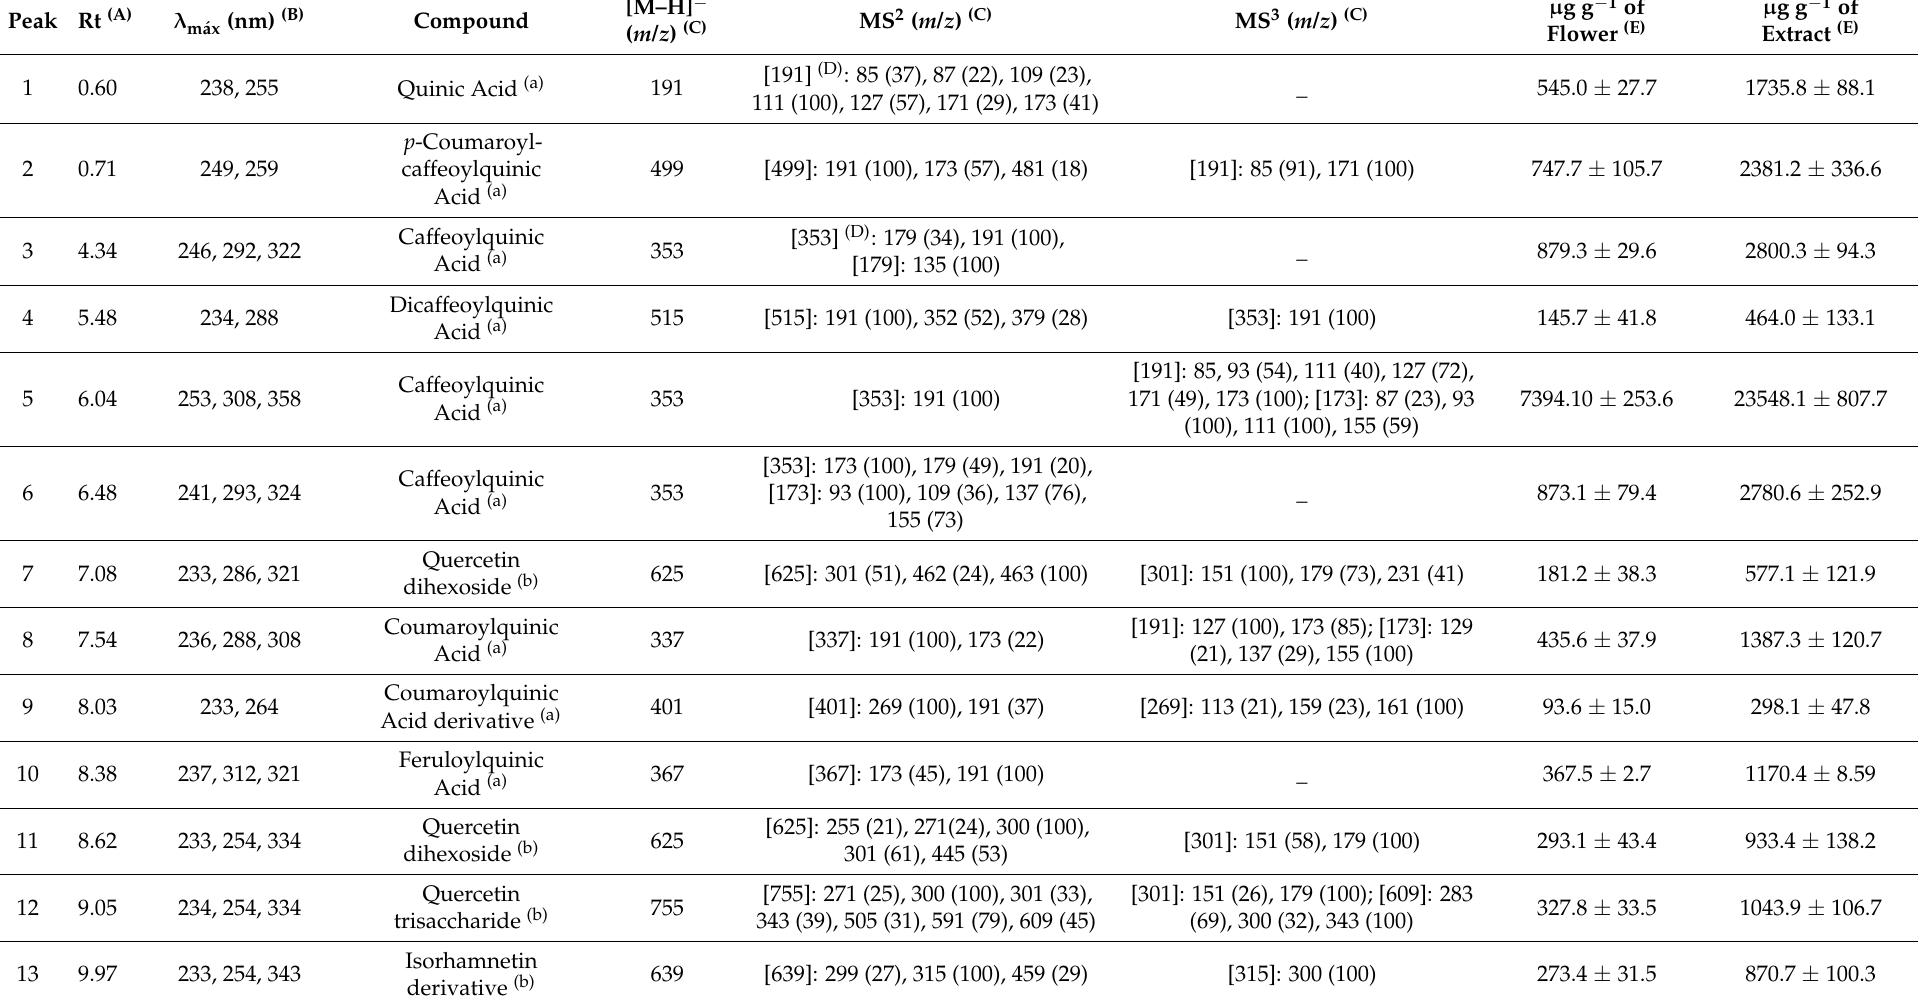
Table 2. Phenolic compounds identification in S. nigra flower aqueous extract by HPLC and corresponding MS n fragmentation